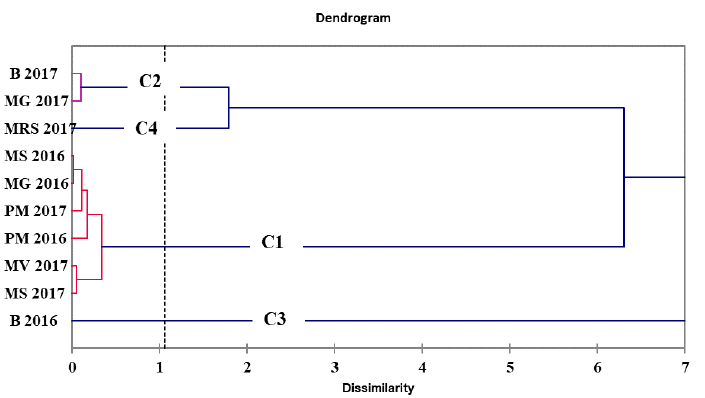
‘Bournette’—B, ‘Marsol’—MS, ‘Marissard’—MRS, Marigoule—MG and ‘Maraval’—MV): C1, C2, and C4—classes grouped by dissimilarities